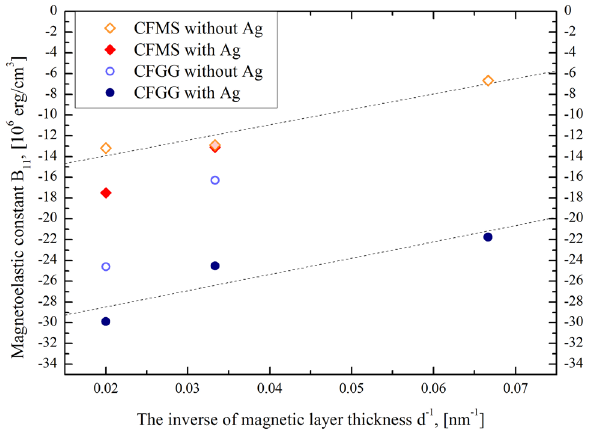
Figure 3. Magnetoelastic constant B 11 for CFMS and CFGG films as a function of the inverse of magnetic layer thickness at room